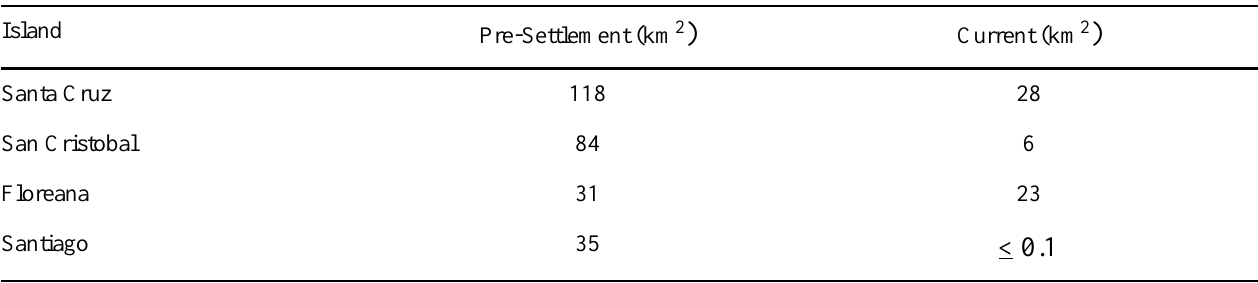
Table 1 . Estimates of the pre-settlement and current area of the Humid Zone on the four islands where Scalesia forest is present, Galapagos. The Humid Zone comprises Scalesia pedunculata forest and a fern– sedge zone on the islands of Santa Cruz and San Cristobal Island Pre-Settlement (km 2